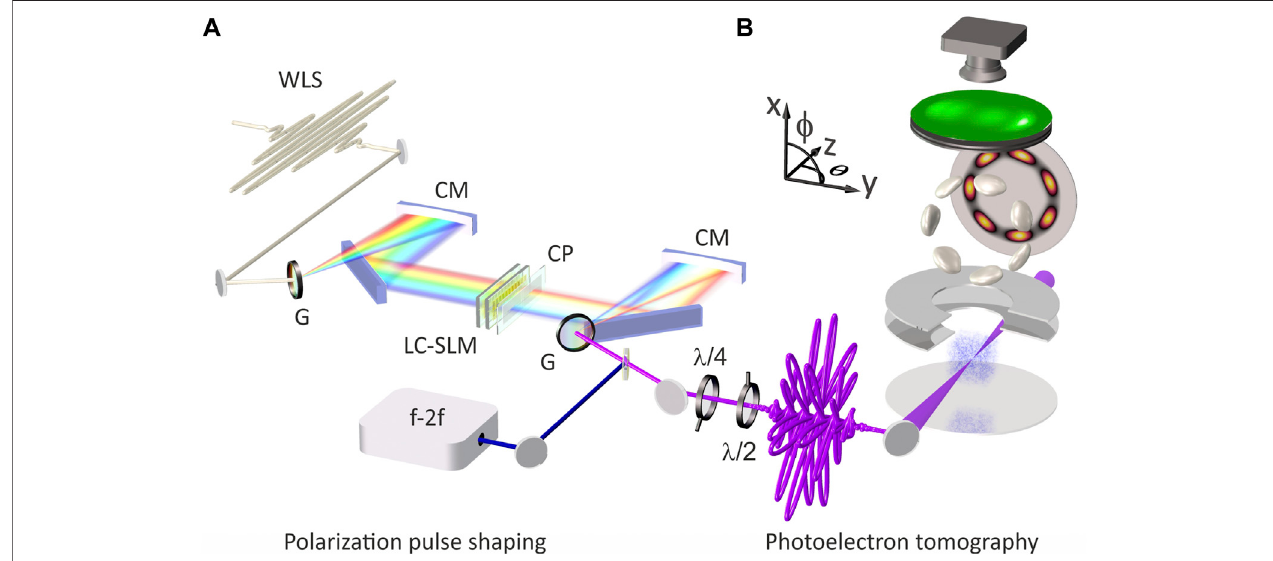
FIGURE3| ExperimentalsetupformultichromaticcoherentcontrolofMPIutilizingawhitelightpolarizationpulseshaper (A) andaphotoelectronVMIspectrometer (B) . Multichromatic amplitude, phase and polarization tailoring of an input WLS is implemented by a speci fi cally adapted polarization shaper in folded 4 f geometry. The WLSinputbeam isspectrally dispersed at the input grating (G), collimated at the cylindrical mirror (CM) and spectrally modulated in the Fourier plane by a dual-layer LC- SLM and a custom composite polarizer (CP). Active CEP-stabilization is realized by an f -2 f interferometer feeding the control loop of the laser system. A superachromatic λ /4 wave plate at the output allows to generate circularly polarized pulse sequences. Using an additional λ /2 wave plate, the shaped laser pulse is rotated about the beam axis, which is the basis for VMI-based photoelectron tomography. The VMI spectrometer on the right consists of an electrostatic lens system projecting the PMD onto an microchannel plate detector attached to a phosphor screen. Images of the resulting 2D projections are recorded with a charge-coupled device camera. Exemplarily, a CRCP (3 ω :4 ω ) output pulse is depicted in magenta along with the tomographically reconstructed 3D PMD created by MPI of potassium